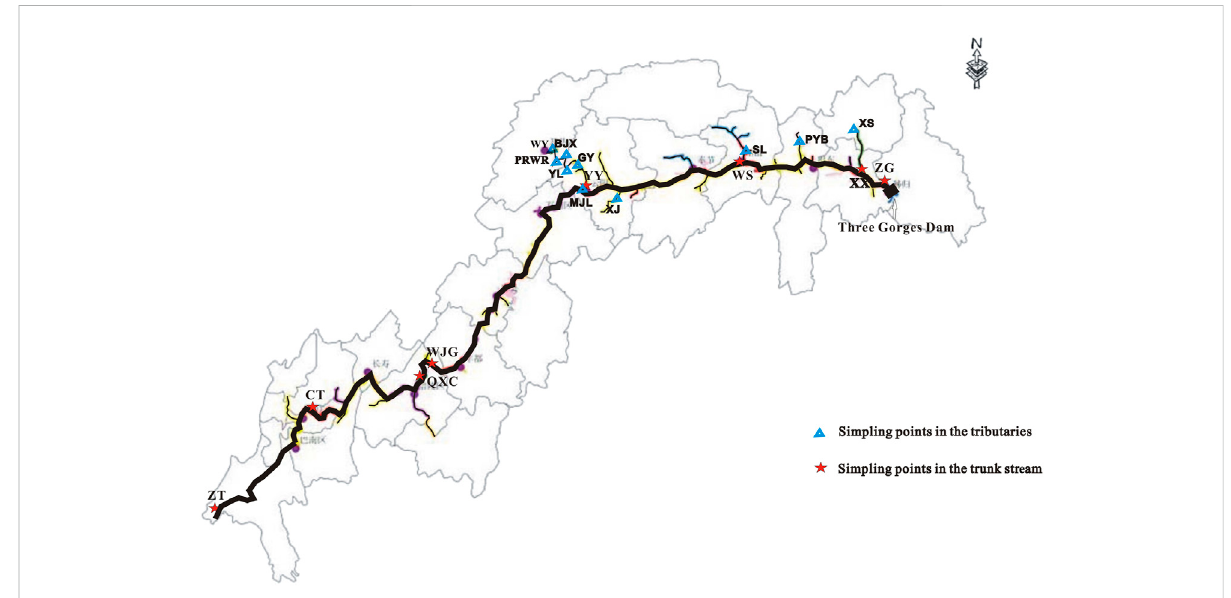
FIGURE 1 Schematic diagram of sampling sites and synthesized sites in the TGR drawdown